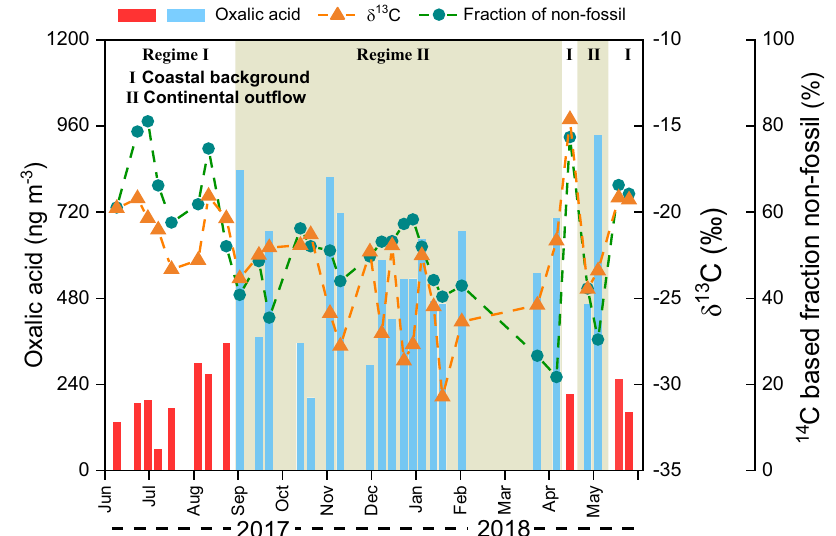
Fig. 2 | Year-round variability of mass concentration and carbon isotopic composition of oxalic acid at the Heshan city. The unshaded periods represent coastal background air mass regime, while the shadowed periods represent con- tinentalout fl owairmass regime.Red and blue bars representthe concentration of